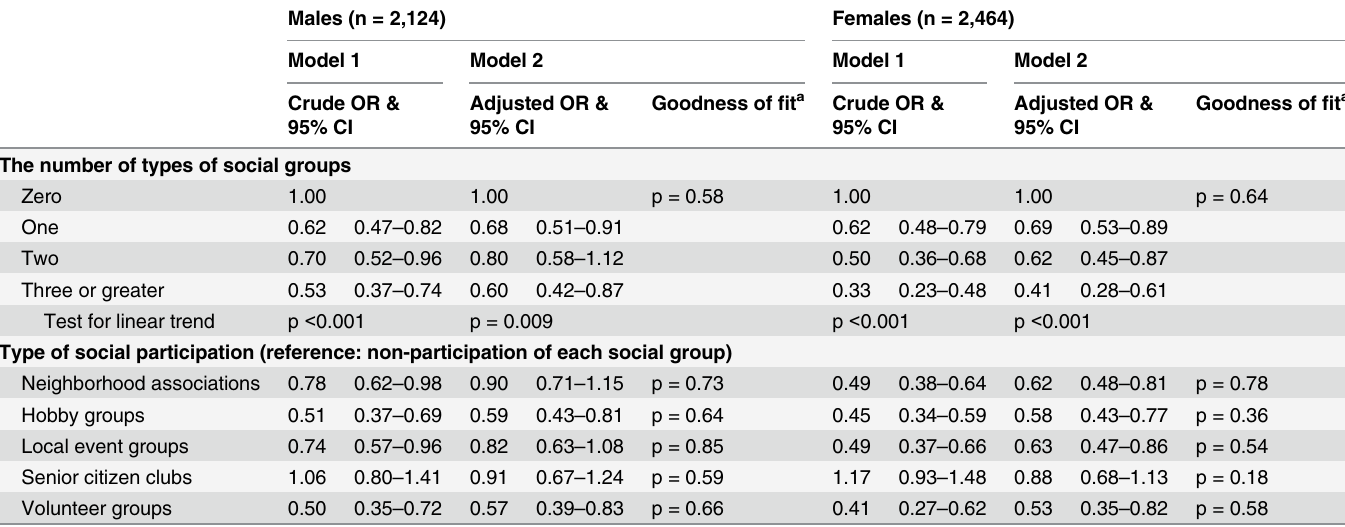
Table 4. Odds ratios (95% confidence interval) for 3-year decline in effectance by gender.